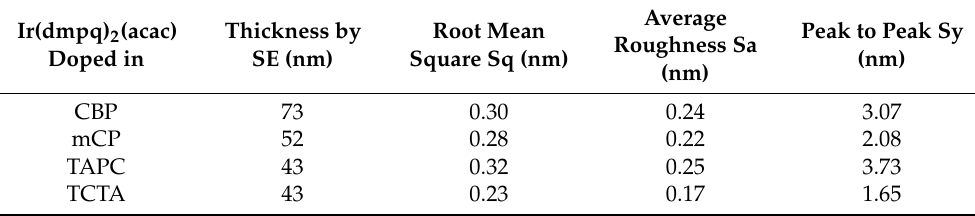
Table 1. AFM and SE results for the spin-coated thin films.